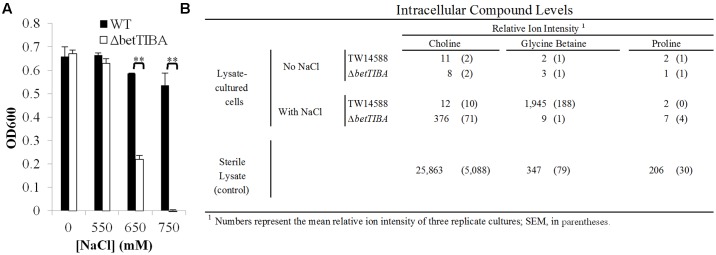
Growth and osmoprotectant accumulation in EcO157 WT and betTIBA mutant cells in lettuce lysates. (A) Growth after 24 h incubation in lettuce lysate amended with 550, 650, or 750 mM NaCl, or an equivalent volume of H2O (0 mM NaCl). Each point represents the mean of determinations from two replicate cultures in wells of a 48-well plate, and standard error of the mean. ∗∗ indicates significant difference by Student’s t-test (P < 0.01). (B) Relative intracellular levels of choline, glycine betaine, and proline in WT and betTIBA mutant cells recovered after 24-h growth in lettuce lysates containing 0 or 650 mM NaCl. Levels of same compounds in sterile lettuce lysates incubated under the same conditions are also shown. Numbers represent the mean relative ion intensity of three replicate cultures, with standard error of the mean provided in parentheses, as determined by MS analysis.